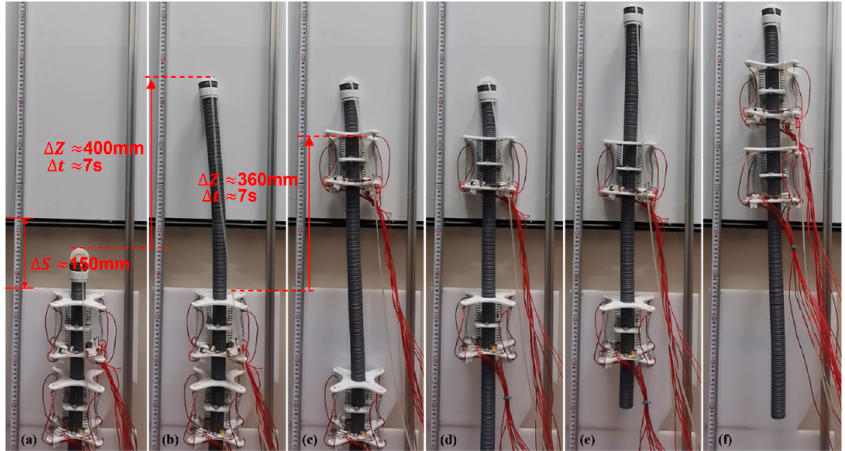
Figure 20. Two-module prototype spans discontinuous surface with large spacing. ( a – f ) represents the motion of the robot.